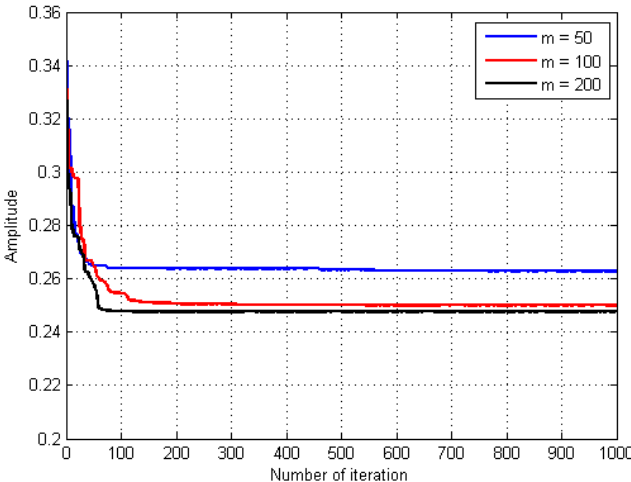
Figure 11. Convergence with different population sizes. Table 4. Computation time with different population sizes.